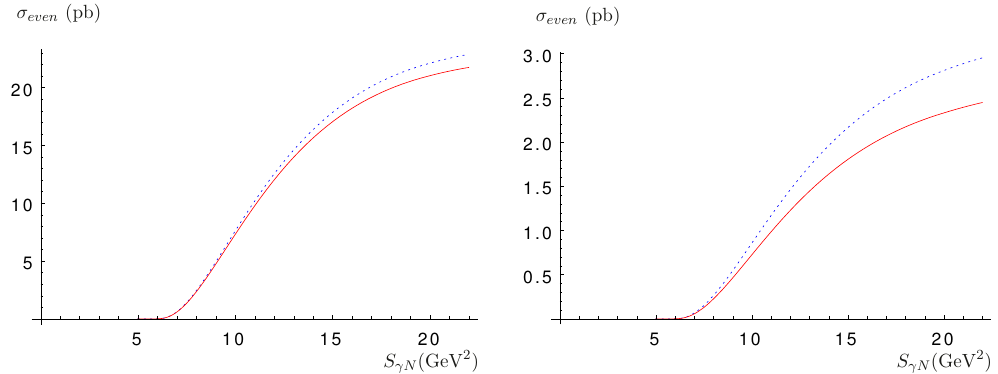
Figure 11 . Integrated cross section for a photon and a longitudinally polarized ρ meson production, on a proton (left) or neutron (right) target. The solid red curves correspond to the “valence” scenario while the dashed blue curves correspond to the “standard” one.